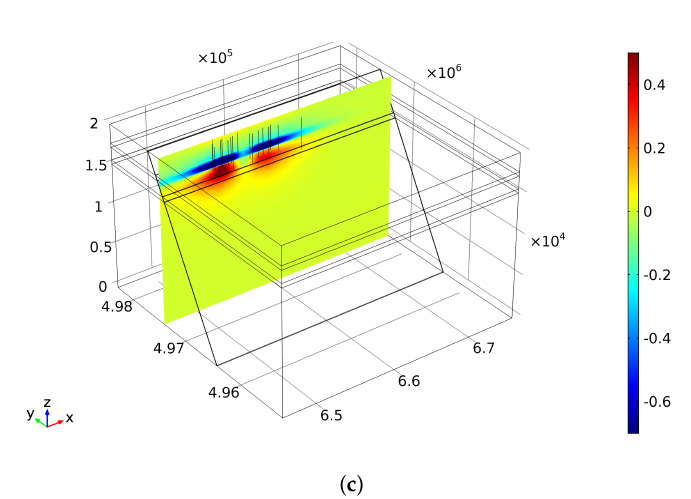
Figure 11. Mirandola fault and Cavone oilfield modeling without in situ stress: Up-dip traction changes d τ in bar ( a ), effective normal stress change d σ (cid:48) (bar) ( b ) and Coulomb Failure Function change dCFF (bar) ( c ). Results are plotted on a vertical plane parallel to x – z plane at the end of simulation, namely after 11,994 days.